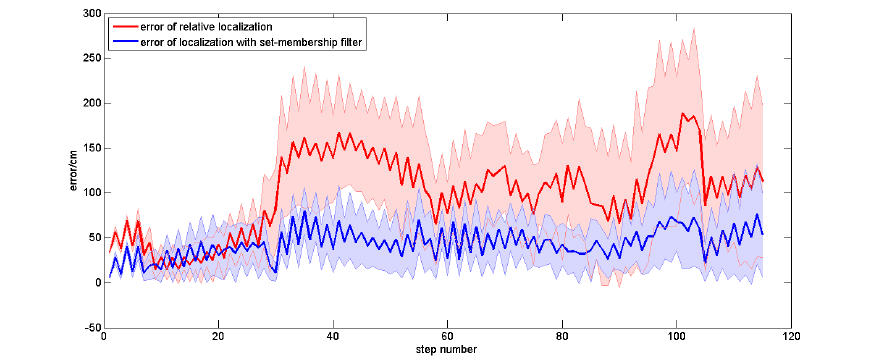
Figure 18. The mean error curves of Subject A walking with normal